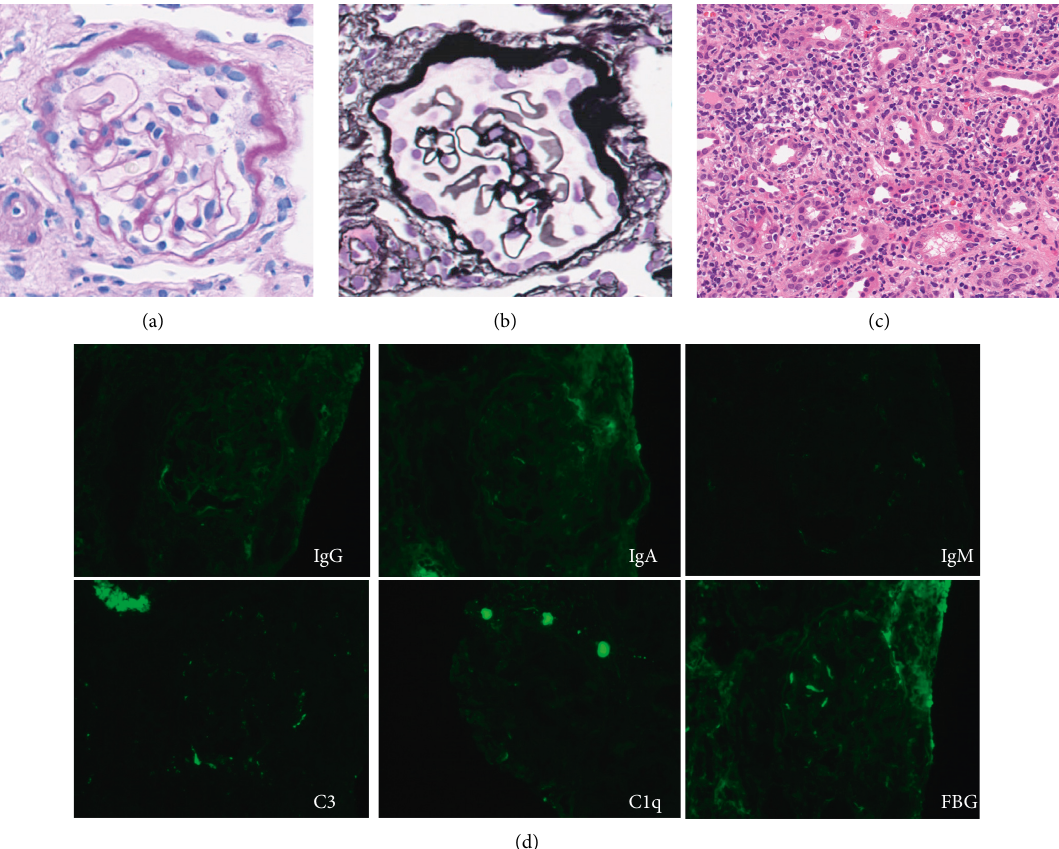
Figure 2: Renal pathological findings of case 1. Light microscopy findings show minor glomerular changes in case 1. Periodic acid-Schiff staining (a, c) and periodic acid methenamine silver staining (b). Immunofluorescence studies show no specific staining for immuno- globulin, complement, and fibrinogen